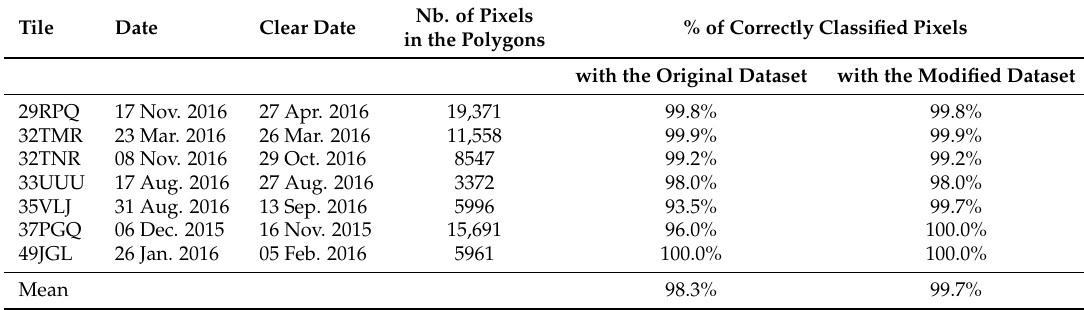
Table 3. Comparison of ALCD masks to Hollstein reference masks on 7 scenes. The mean is weighted by the number of pixels in the